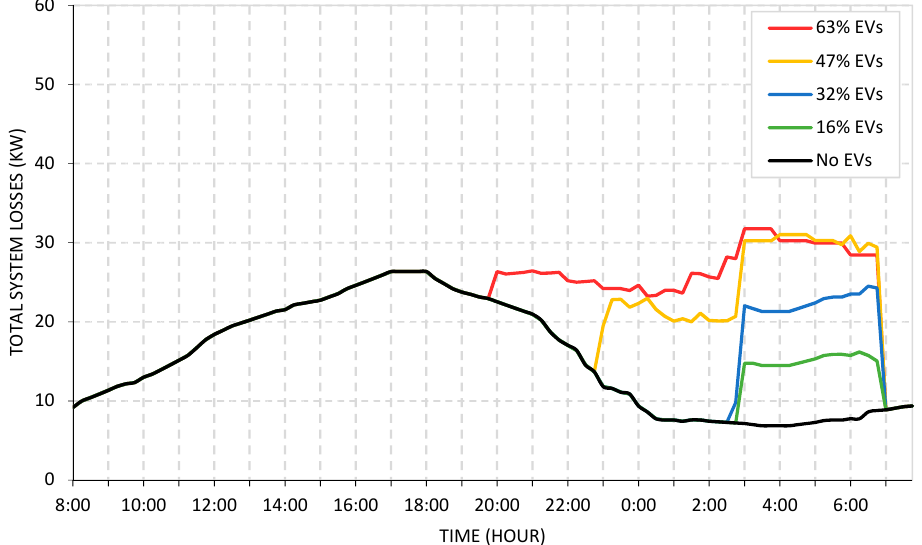
Figure 14. Impact of coordinated EVs’ charging optimal starting time on power losses of system.